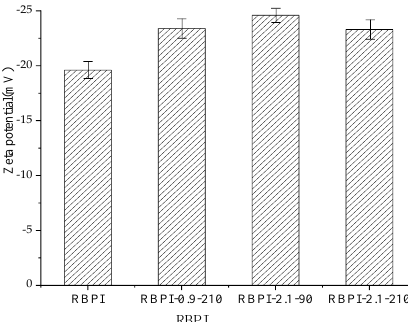
Figure 8. Zeta potential ( ζ) of RBPI prepared from different SFE pretreatment